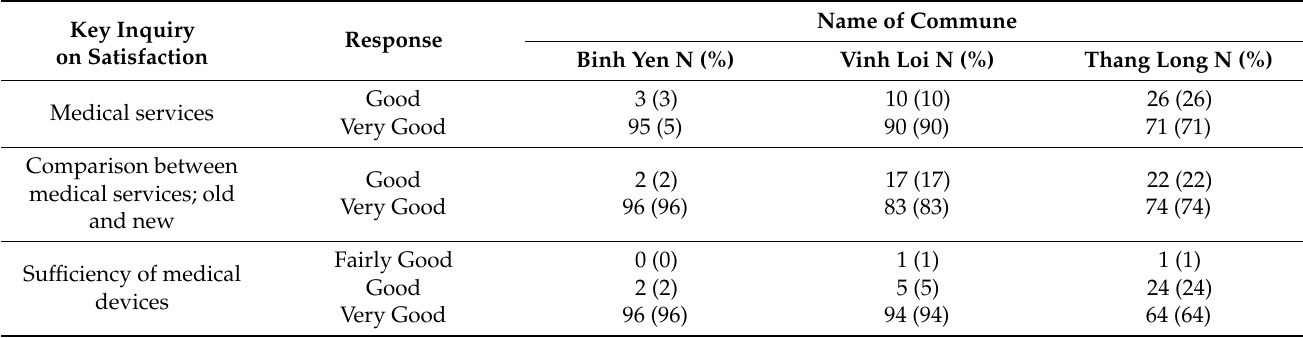
Table 6. Participants’ satisfaction with the medical services offered by the CHSs.